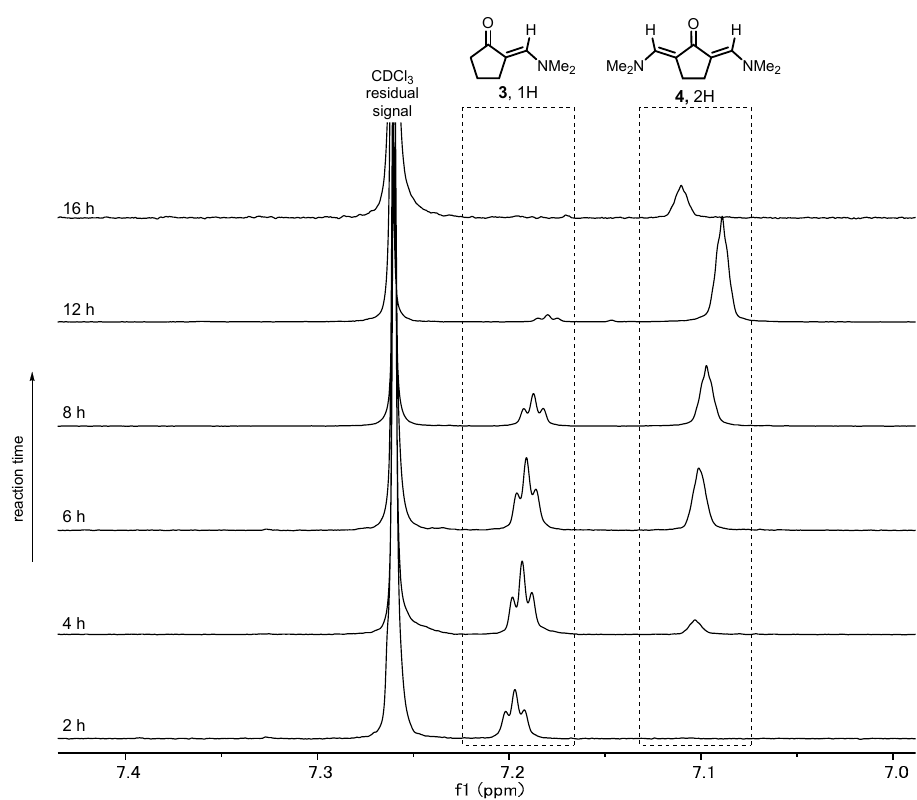
Figure 1. 1 H NMR profile (products 3 and 4 ) for the reaction of cyclopentanone (3.4 mmol), N , N -dimethylformamide dimethyl acetal (13.6 mmol) and DBU (0.36 mmol) at 165 °C for 2 h followed by 14 h at 190 °C.